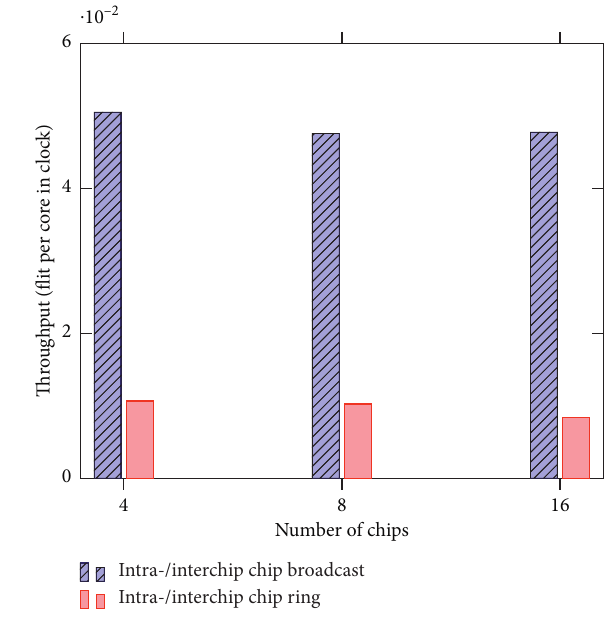
Figure 14: The throughput of the proposed THz multichip system in comparison with the token-based mm-wave one with varying system size (PIR � 0.5).